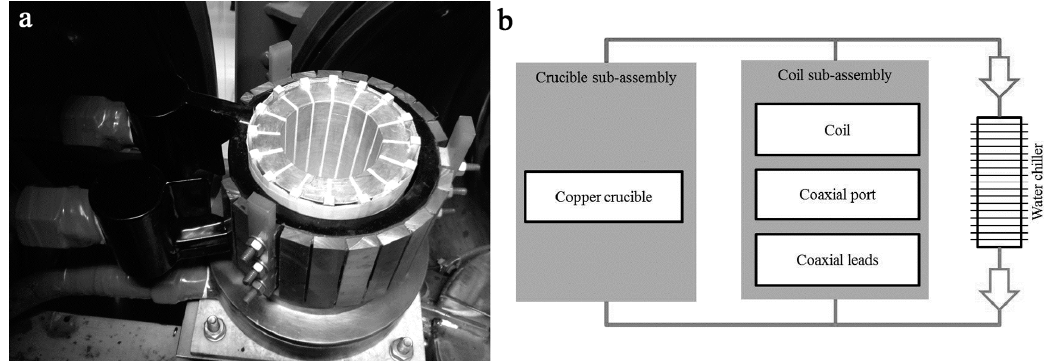
Table 1. Physical properties of Ti-6Al-4V